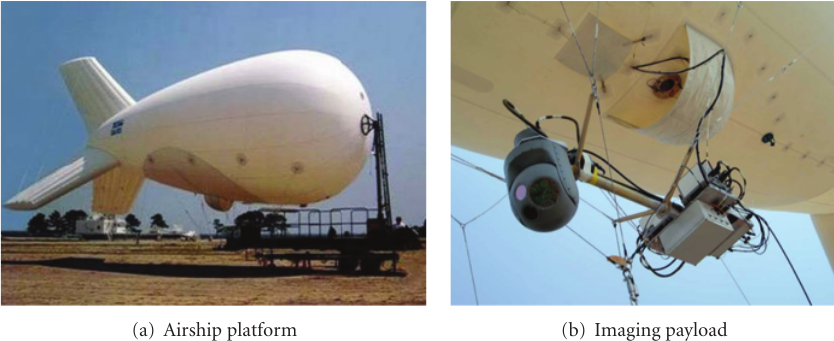
Figure 1: RAID system of U.S